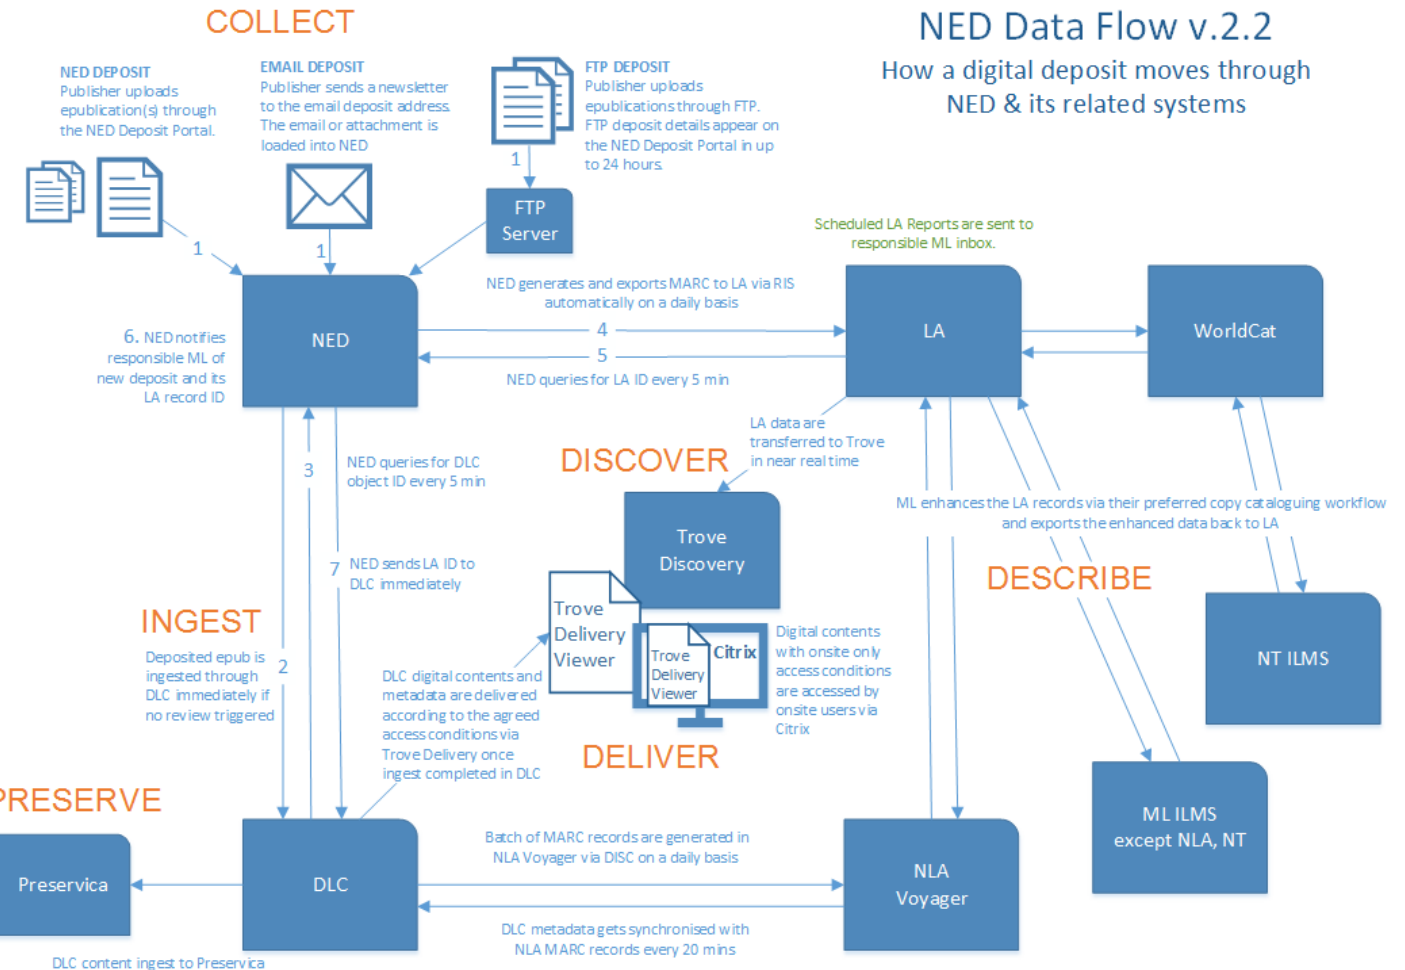
Figure 2. Data flow in NED.